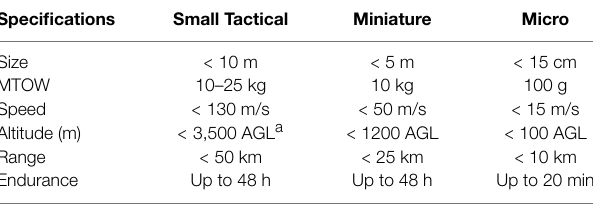
TABLE 2 | UAVs classification proposed in Arjomandi et al. (2006).